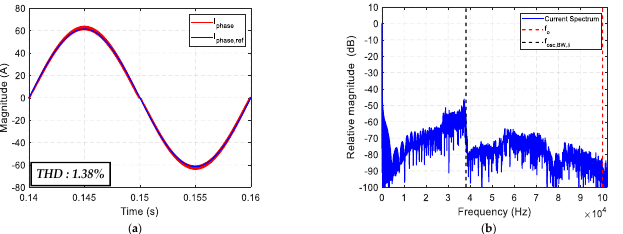
Figure 10. ( a ) Input current controlled by analog PSSOCC and ( b ) its related current spectrum. The current controlled by DSPSSOCC follows its reference with a very low THD of 1.37%. The spectrum analysis confirms this value with a strong reduction of low fre-